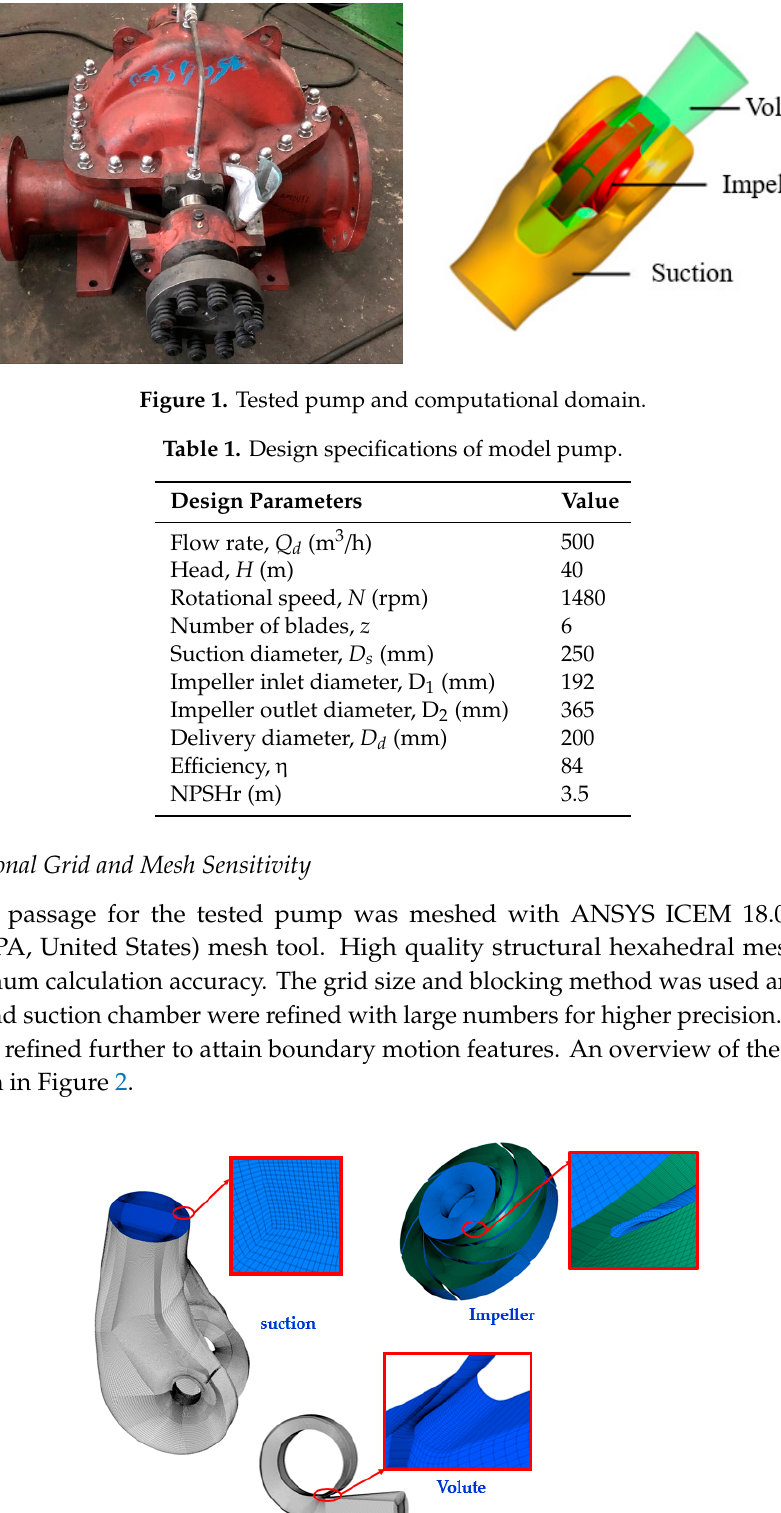
Figure 3. Performance comparison for 5 independent grids. Based on similar works [17,27,28], 5 independent high quality structural hexahedral meshes were built and a grid sensitivity analysis executed. Simulations were performed at the design flow rate of to determine the mesh influence on pump head and efficiency. The effects of the mesh density on the hydraulic performance remained fairly constant when the number of grid elements increased past 4.26 × 10 6 elements, suggesting that numerical accuracy gradually stabilized as the grid number increased. The mesh density with elements 4,266,423 was therefore used for the computations to reduce calculation load and computation time. Statistics for the selected mesh density is presented in Table 2, and the grid sensitivity of the 5 independent mesh generated is shown in Figure 3. Table 2. Grid cells of the selected mesh. Domain